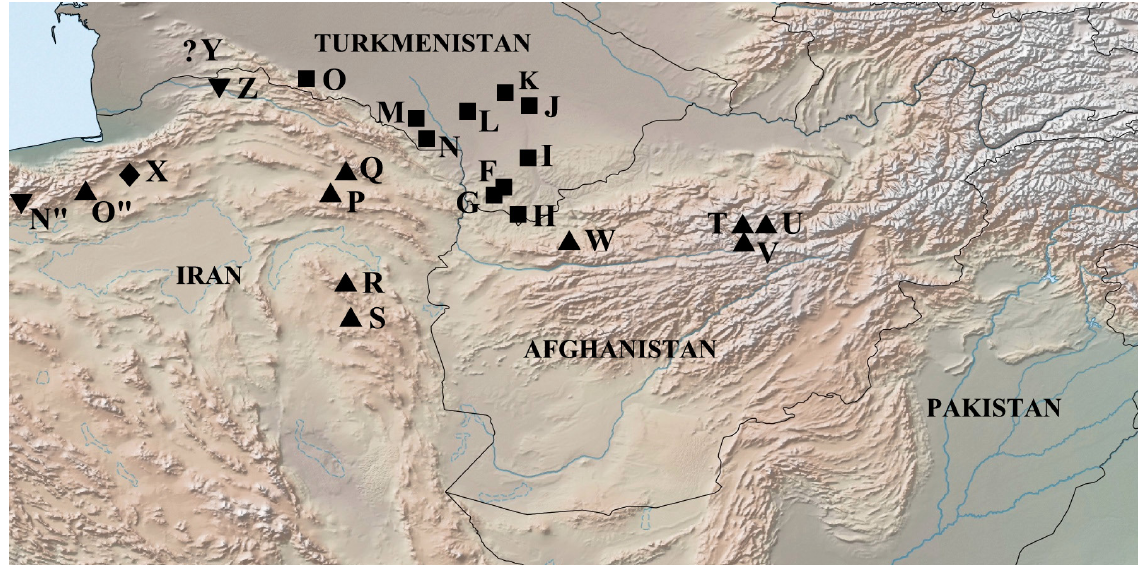
Fig. 14. Distribution of Melitaea timandra timandra Coutsis & van Oorschot, 2014, M. timandra binaludica subsp. nov. and M. shahvarica sp. nov. For a description of the points by letters, see Fig. 30. = Melitaea timandra timandra ; = Melitaea timandra binaludica subsp. nov.; = Melitaea shahvarica sp. nov.; ? = unconfirmed finds of Melitaea timandra ; = Melitaea timandra with uncertain subspecies